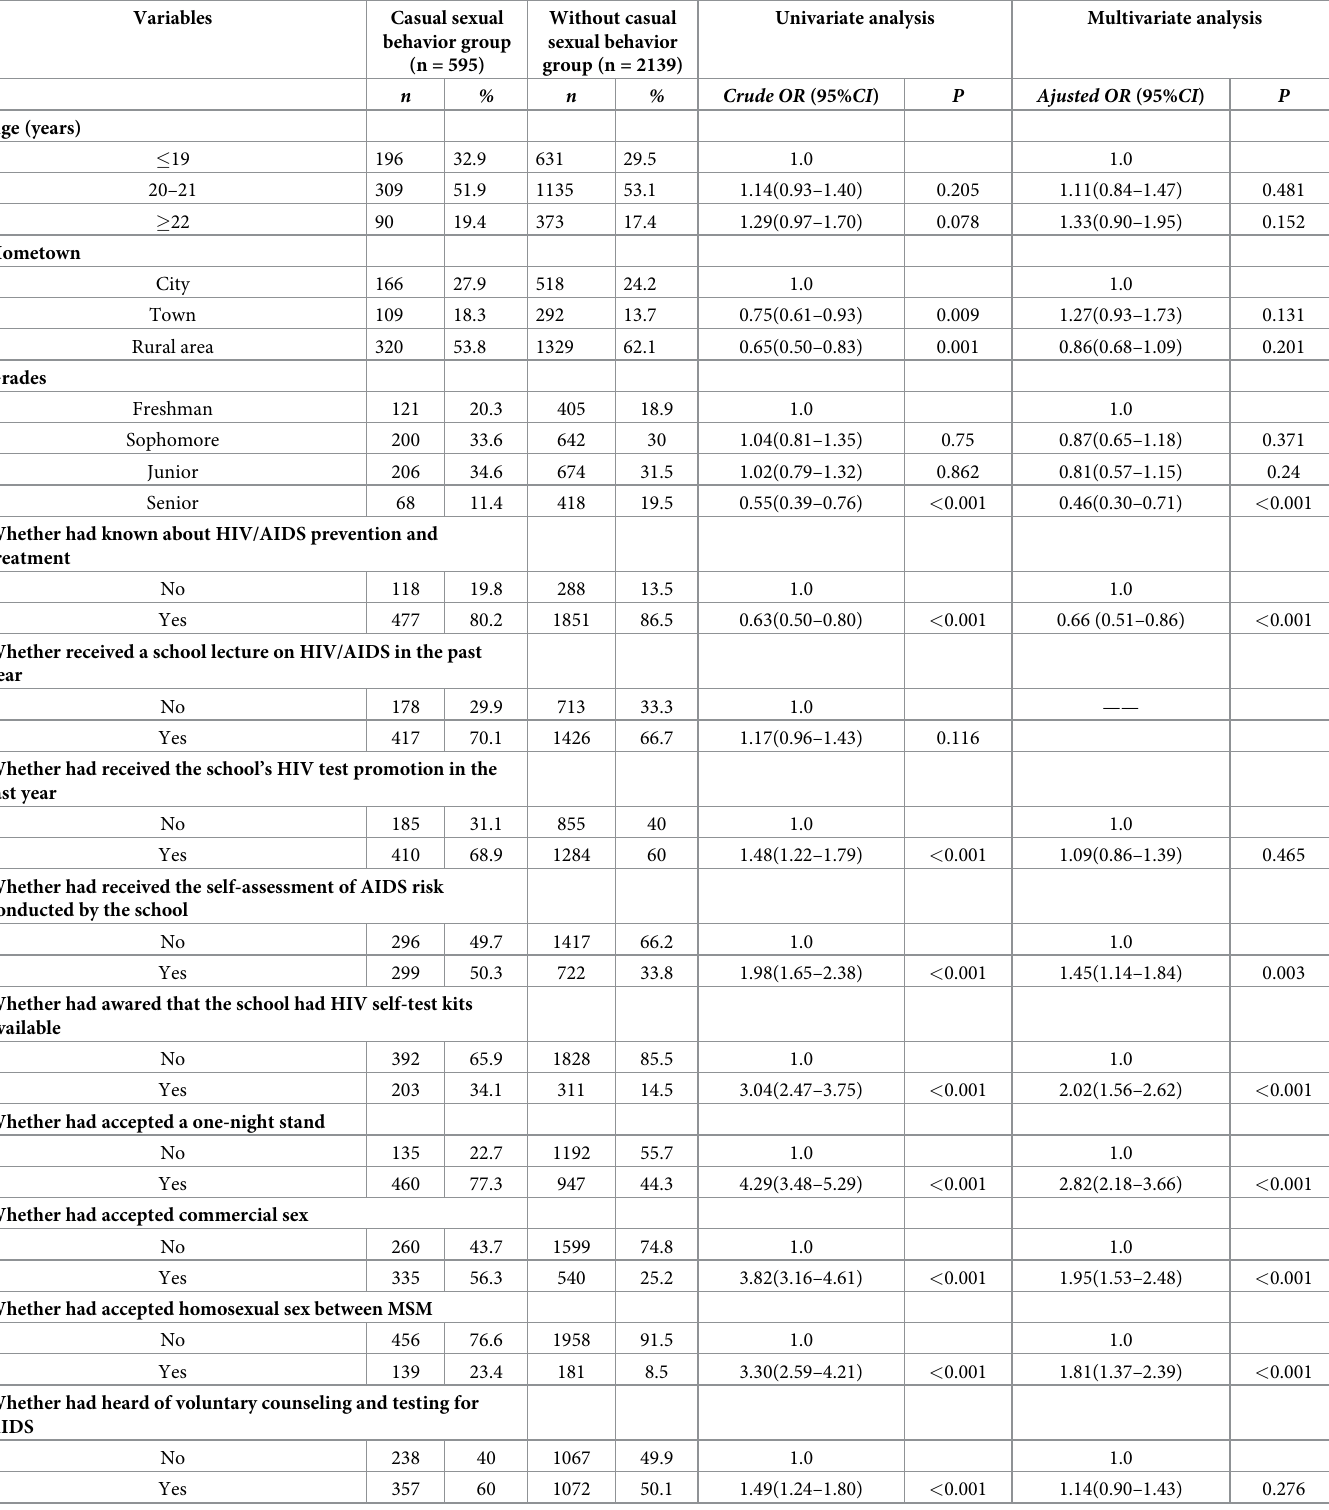
Table 3. Analysis of factors influencing casual sexual behavior among male college